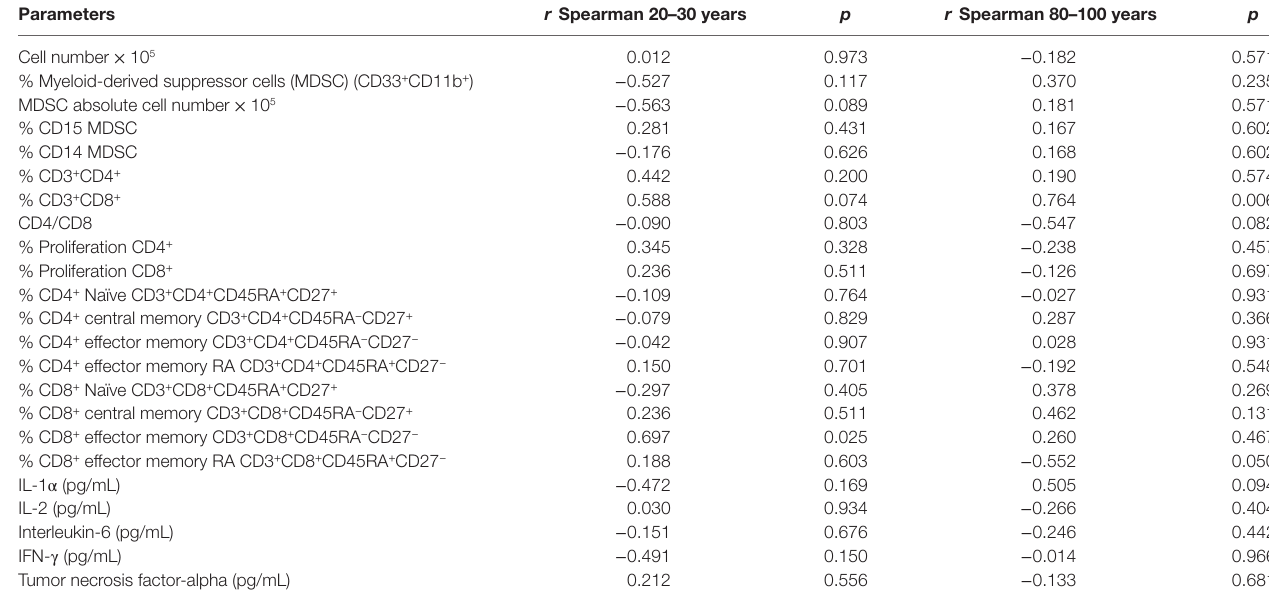
Table 4 | Vitamin D [25(OH)D3] levels and correlation with parameters of the immune system in young (20–30 years) and old (80–100 years) individuals.